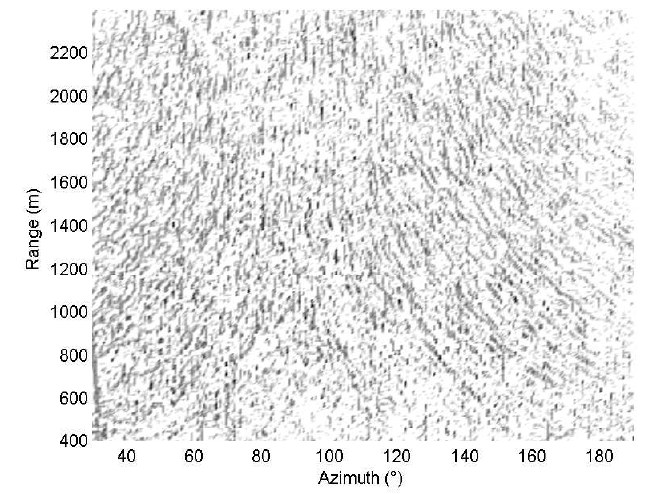
Figure 5. The obtained edge image after superimposing the eight directional edge images.